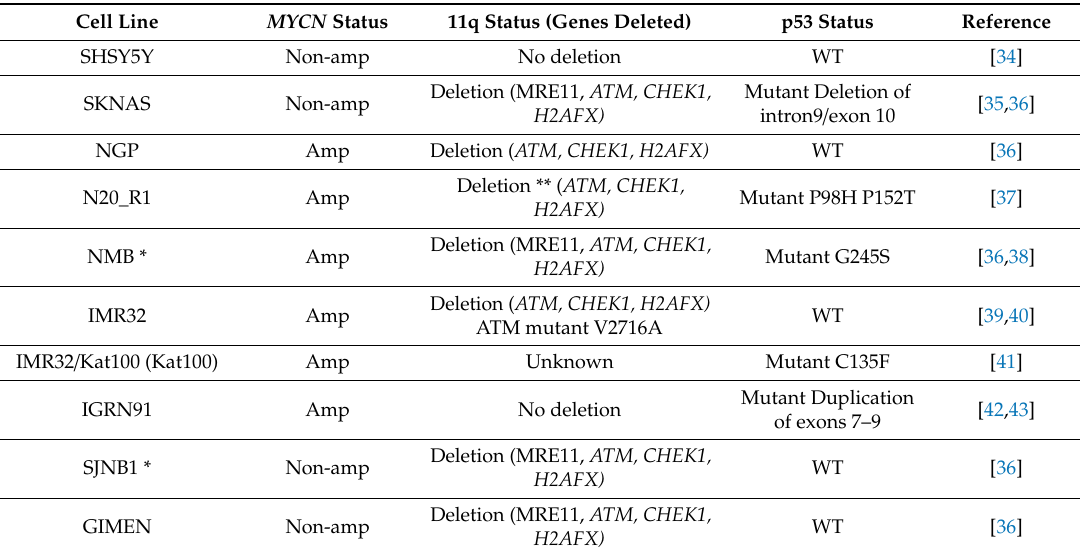
Table 1. Cell line genetic